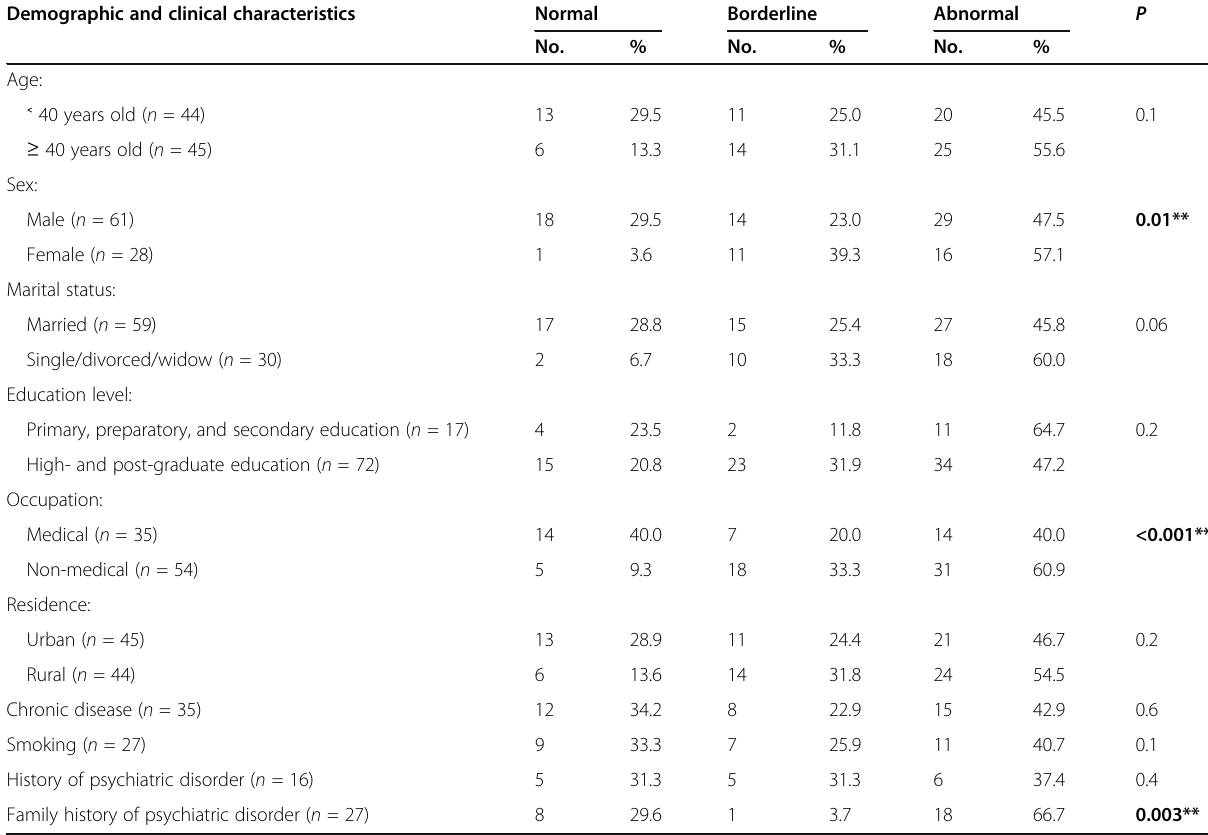
Table 4 Association between HADS – Depression and demographic and clinical characteristics of the studied patients Demographic and clinical characteristics